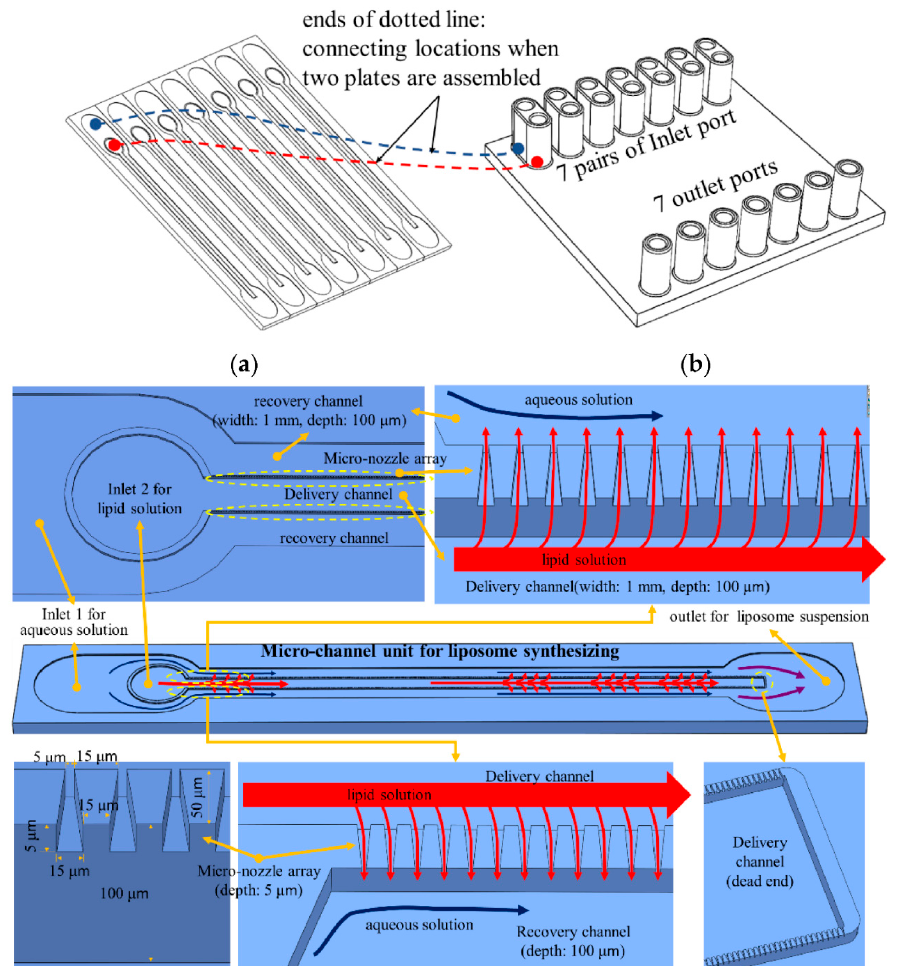
Figure 17. Microfluidic device designed by Woo et al.: ( a ) microchannel plate; ( b ) cover plate. ( c ) Schematic representation of the unit liposome-synthesizing microchannel. Reprinted from an open-access source [76].